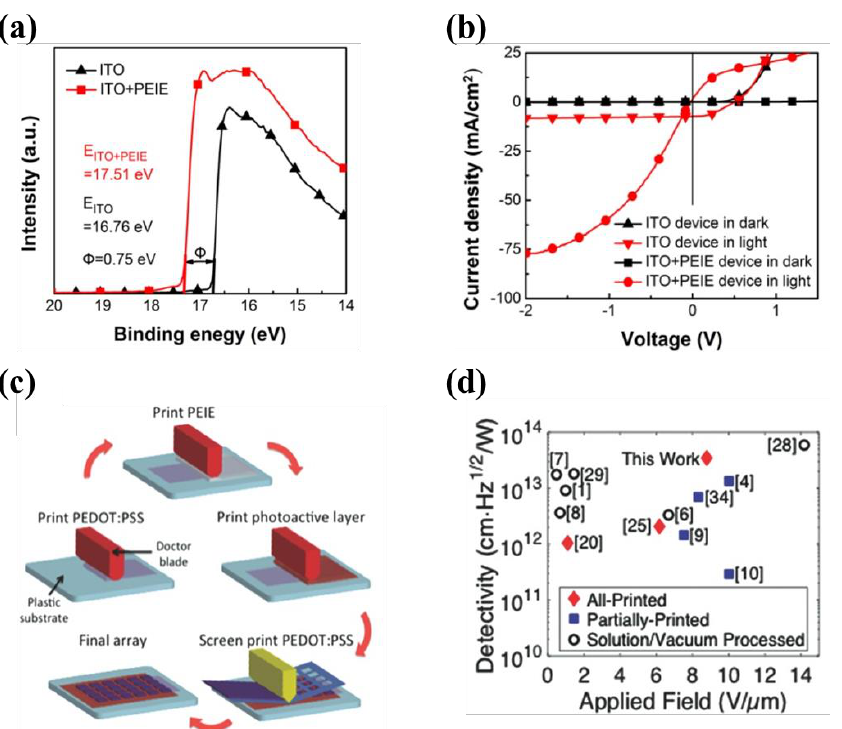
Figure 7. ( a ) UPS spectra of the pristine ITO and PEIE-modified ITO electrodes; ( b ) J-V curves of the OPD on ITO and ITO + PEIE (under AM 1.5 100 mW · cm − 2 ). (Reproduced with permission from [69]. OSA Publishing, 2017). ( c ) Fabrication process of all-printed organic photodiodes (OPDs); ( d ) Comparison of D* at various applied fields for all-printed OPDs and other OPDs published in the literature. (Reproduced with permission from [70]. WILEY Publishing,